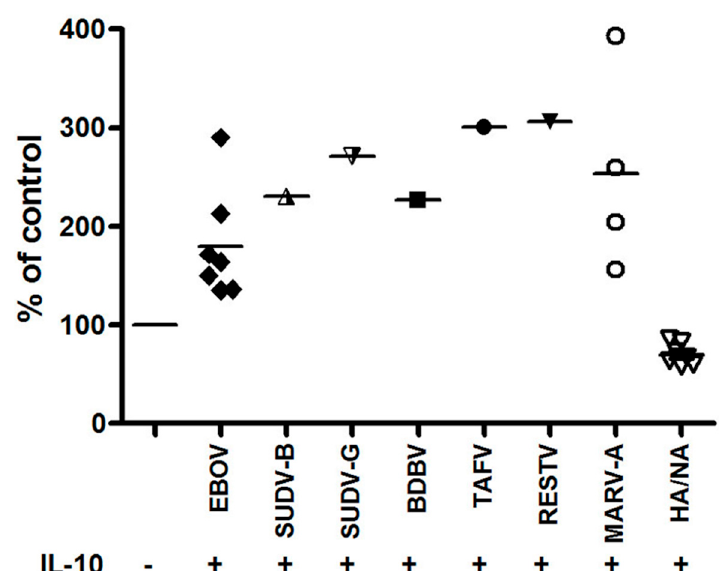
Figure 3. IL-10 enhances fusion of primary MDM with VLPs pseudotyped with envelope glycoproteins from all clinically significant filovirus species. Cells were pre-incubated with 20 ng/mL IL-10 or DPBS supplemented with 0.5% HSA (mock treated), infected, loaded with CCF2/AM, processed and analyzed by Flow cytometry as described in Materials and Methods. The figure summarizes the results from several different experiments, utilizing MDM from a total of seven different donors. In each experiment, MDM were infected with EBOV Kikwit GP VLP (solid diamonds) in parallel with one or more different VLP types, pseudotyped with the surface glycoprotein of one of the indicated filovirus species. Data from one of the individual donors are presented in Supplemental Figure S3. Influenza HA/NA pseudotyped virus particles served as a control (open triangles).